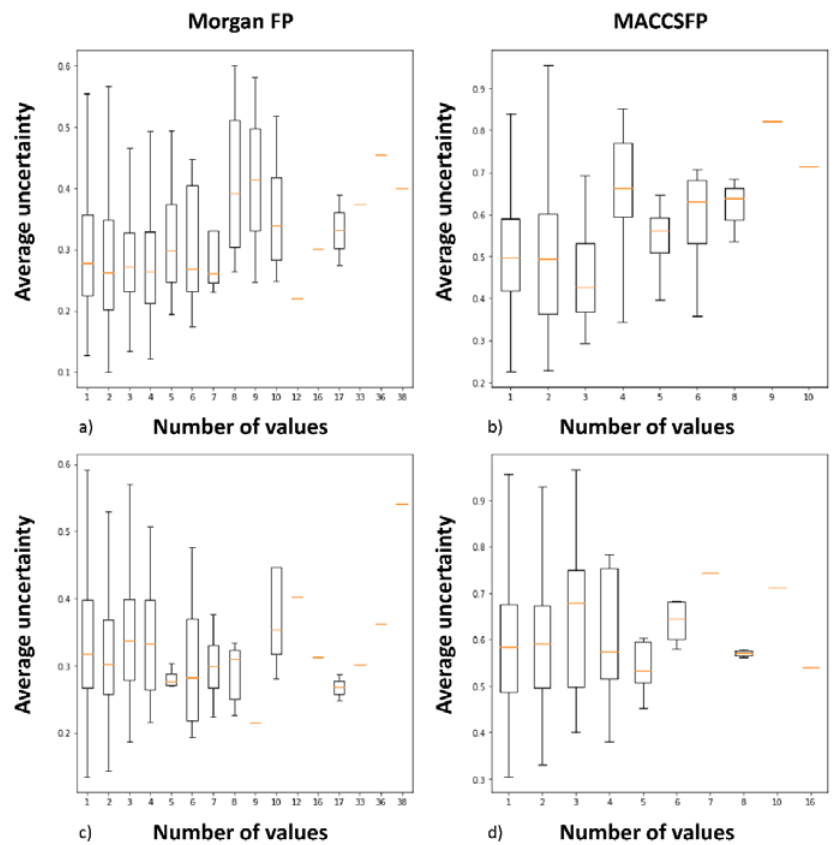
Figure 2. Analysis of dependency between prediction uncertainty and number of activity values provided for particular compound in the ChEMBL database for dopamine D 2 ligands. ( a ) for Morgan FP in CV experiments; ( b ) for MACCFP in CV experiments; ( c ) for Morgan FP in BAC experiments; ( d ) for Morgan FP in BAC experiments .